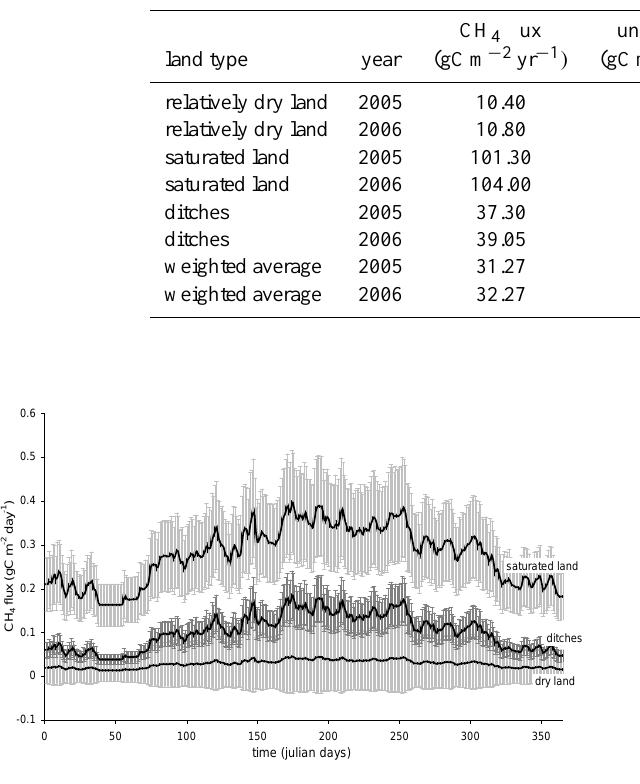
Fig. 8. Modelled daily CH 4 fluxes for relatively dry land, saturated land and ditches over 2005. Error-bars indicate the variance error from the regression